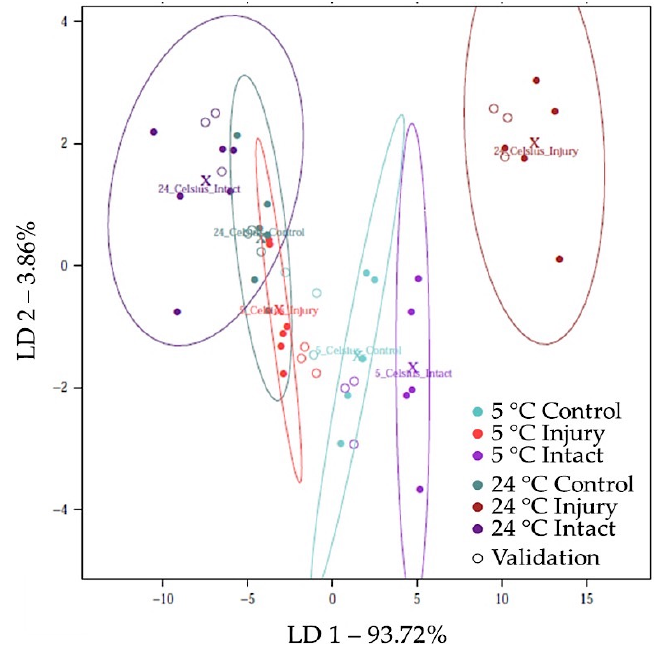
Figure 4. LDA classification model on the e-tongue data of control and infected raw plum juices with second parallel sample validation when the different treatment groups were used as class variables ( N = 51).